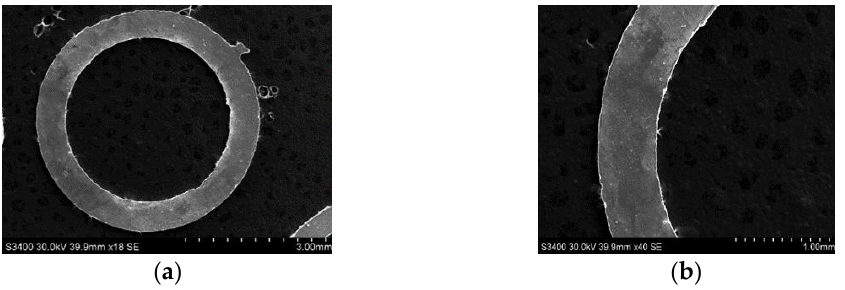
Figure 16. The scanning electron microscopy (SEM) photographs of the final aluminum ring: ( a ) integral photograph; ( b ) local photograph.